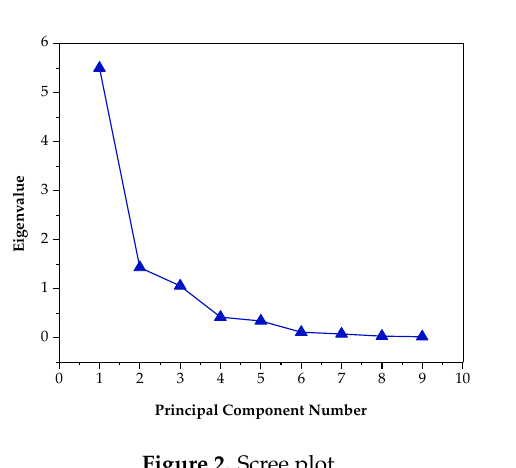
Figure 1. Standardized data.